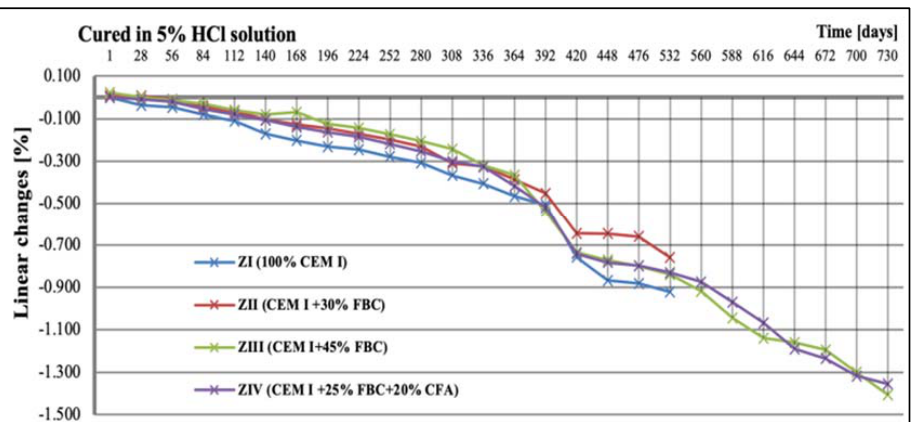
Figure 13. Linear changes of mortars cured in 3% HCl solution for 730 days.